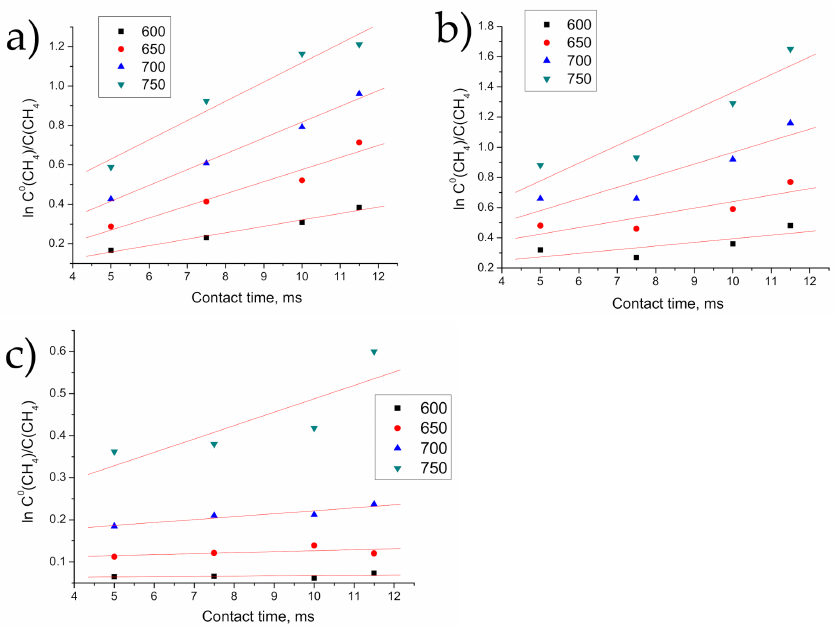
Figure 13. The dependences of logarithm of methane concentrations ratio on contact time at different